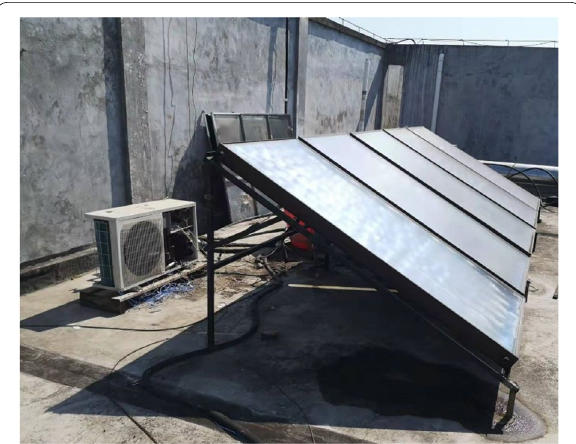
Fig. 2 Experimental